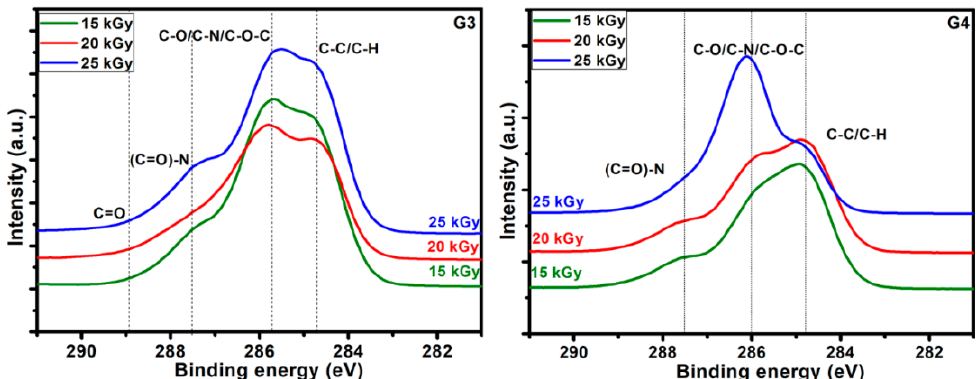
Figure 6. High resolution spectra in the C1s region for the G3 hydrogels and respectively G4 hydrogels.